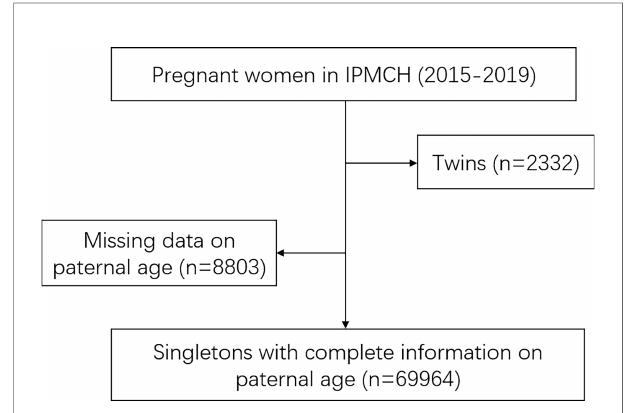
FIGURE 1 | Flow chart: 69,964 cases are enrolled in this